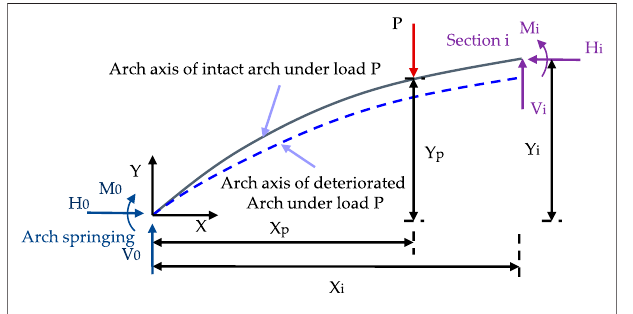
FIGURE 15 | Sectional internal force diagram of the deteriorated arch.